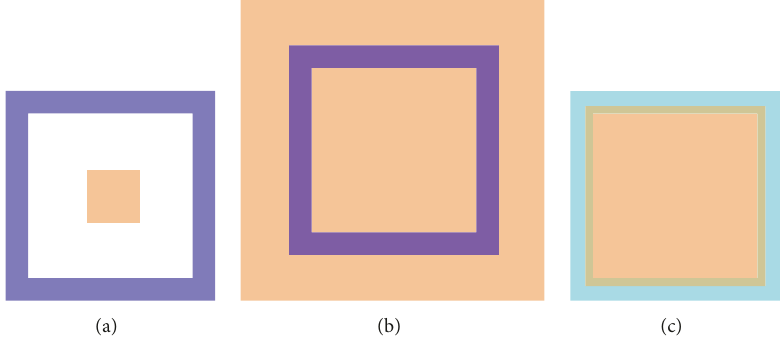
Figure 6: The orange solid square needed to be scaled (not too small as in (a), and not too large as in (b)) to match the dimensions of blue empty square (c).